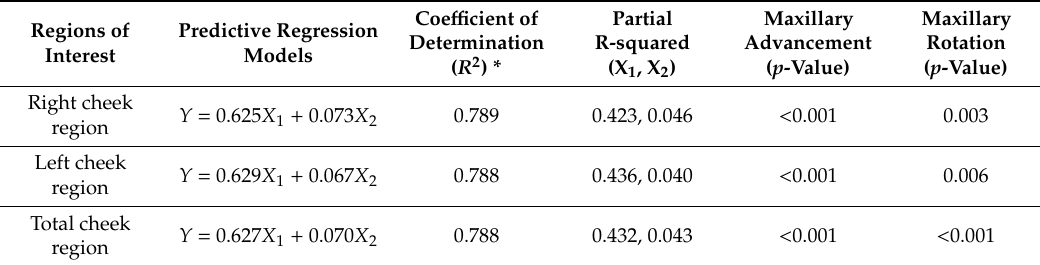
Table 5. Multiple linear regression analyses and models of the relationships between the anteromedial cheek soft tissue movements and maxillary advancement and rotational movements.